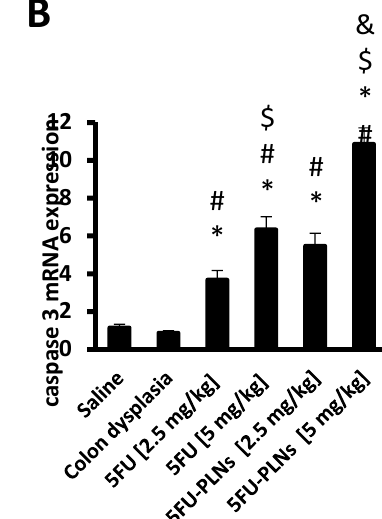
Figure 6. mRNA expression of p53 and caspase 3 genes in colon specimens. mRNA expression of p53 ( A ) and caspase 3 ( B ). Data are mean ± SDM and compared at p less than 0.05. *: Versus saline group; #: Versus colon dysplasia group; $: Versus 5FU [2.5 mg/kg] group; &: Versus 5FU [5 mg/kg] group; ^: Versus 5FU-PLNs [2.5 mg/kg] group.